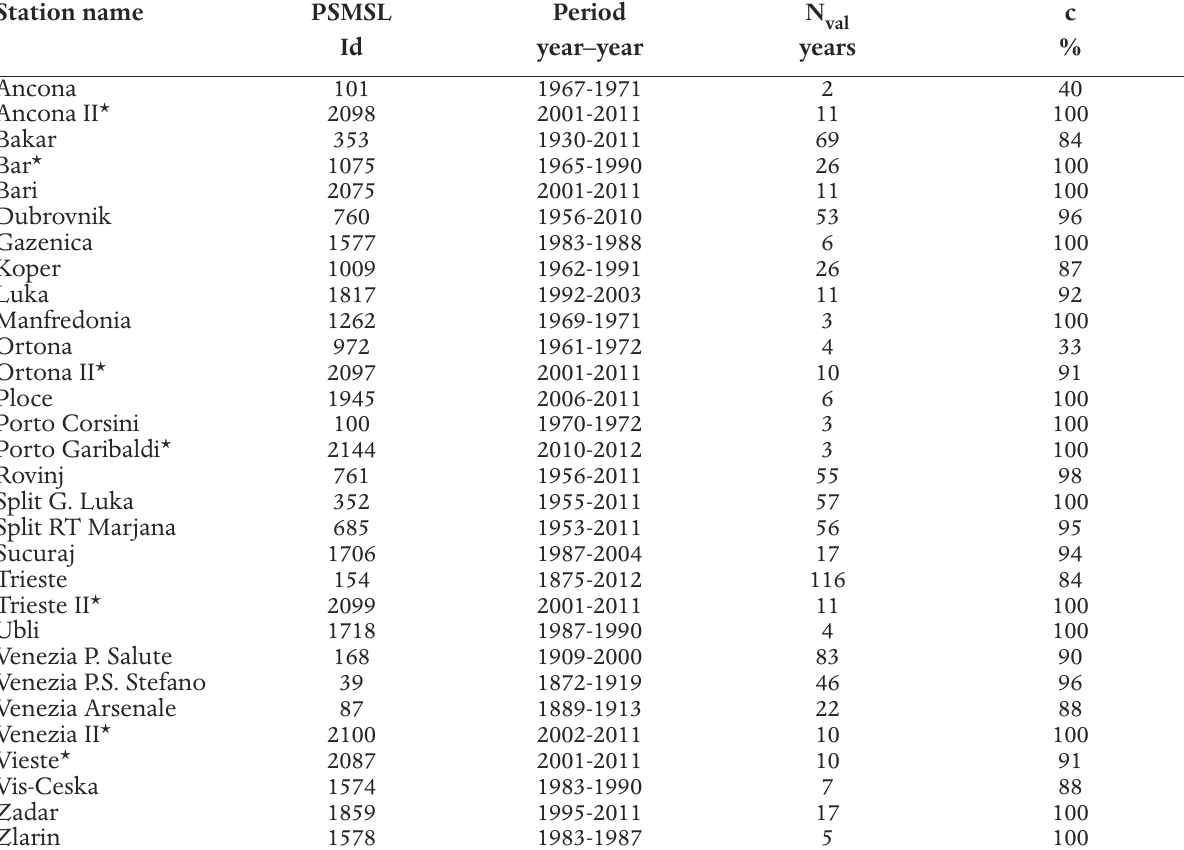
and c denote, for each time val